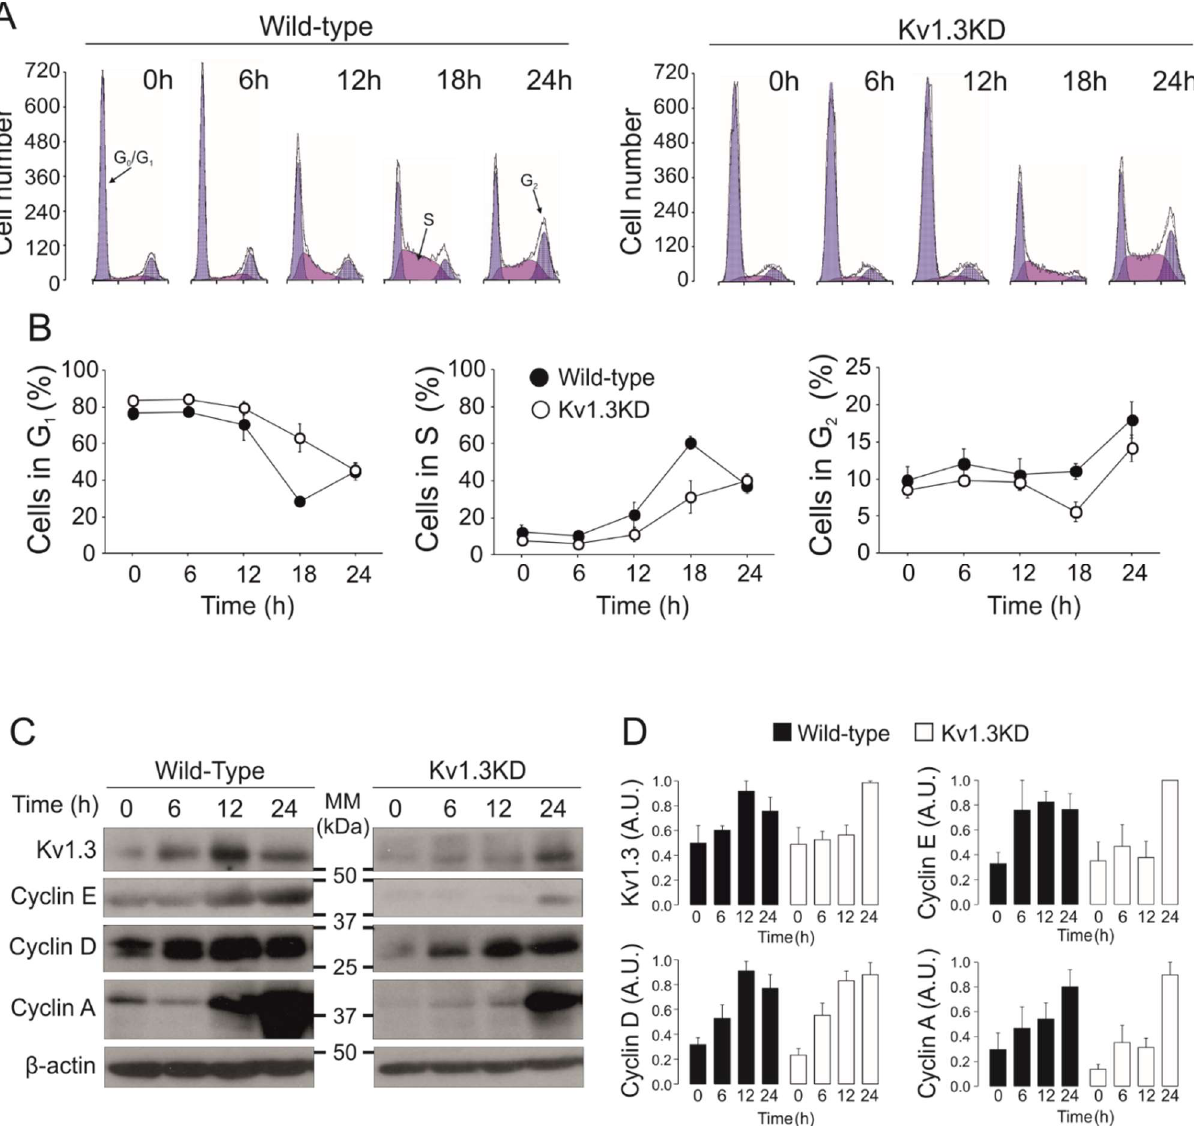
Figure 2. Kv1.3 facilitates the G1/S transition of the cell cycle in preadipocytes. Serum-starved resting cells were incubated for the indicated time after serum readdition. ( A ) Cell cycle analysis of 3T3-L1 preadipocytes was performed with propidium iodide. Representative histograms at 0, 6, 12, 18 or 24 h after serum readdition. The cells exhibit two blue peaks corresponding to the G0/G1 (left) and G2 (right) phases. The cell population in purple corresponds to cells in the S phase. Left panels, wild-type preadipocytes; right panels, Kv1.3KD preadipocytes. ( B ) The % of cells in the G0/G1 phase, % of cells in the S phase and % of cells in the G2 phase for wild-type (black) and Kv1.3KD (white) preadipocytes. The data are the mean ± SE ( n = 4–10 independent experiments). Two-way ANOVA indicated p < 0.001 (***) in the G0/G1 phase and p < 0.01(**) in the S phase between wild-type and Kv1.3KD preadipocytes. ( C ) protein expression of Kv1.3, cyclin E, cyclin D1 and cyclin A. ( D ) Relative protein expression from the data in C. The values were relative to 0 h for each condition and normalized to the level of β-actin, which was used as a loading control (wild-type, black columns; Kv1.3KD, white columns). The data are the mean ± SE ( n ≥ 3). * p < 0.05 between WT and Kv1.3KD at 12 h in Kv1.3 and cyclin E (Student’s t test).